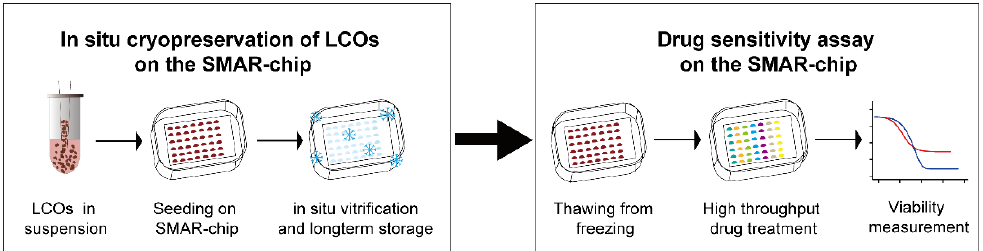
Figure 1. Diagram of the in situ freeze–thaw cycle and the subsequent drug sensitivity test on the